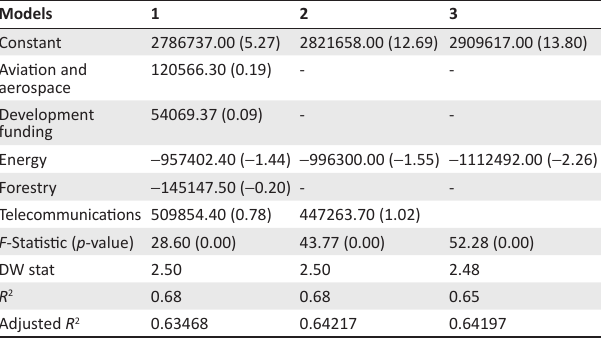
TABLE 7: Regression analysis – fixed pay and company industry.